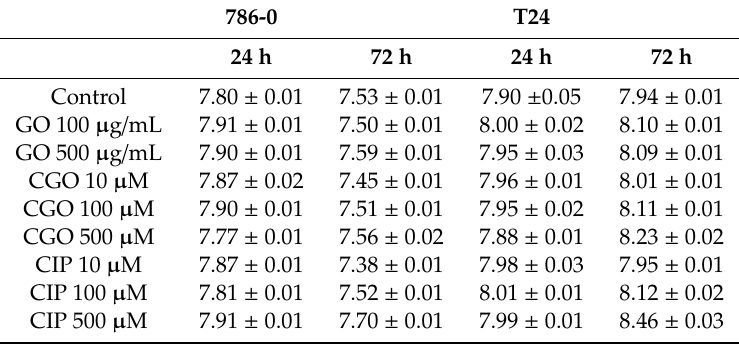
Table 1. pH medium level after 24 and 72 h cell